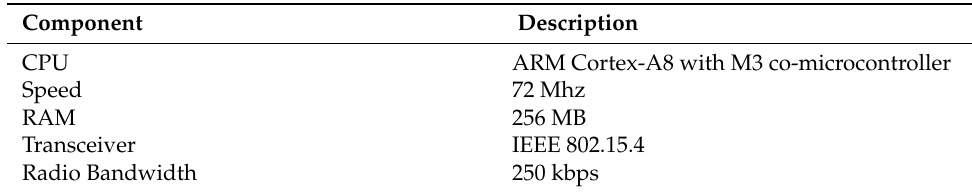
Table 3. A8 device